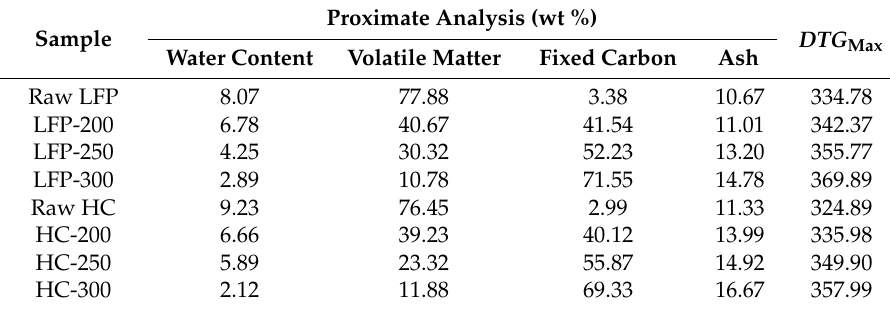
Table 2. Proximate Analysis of LFP Powder and HC with their Carbonized Samples Resulting from HTC at Different